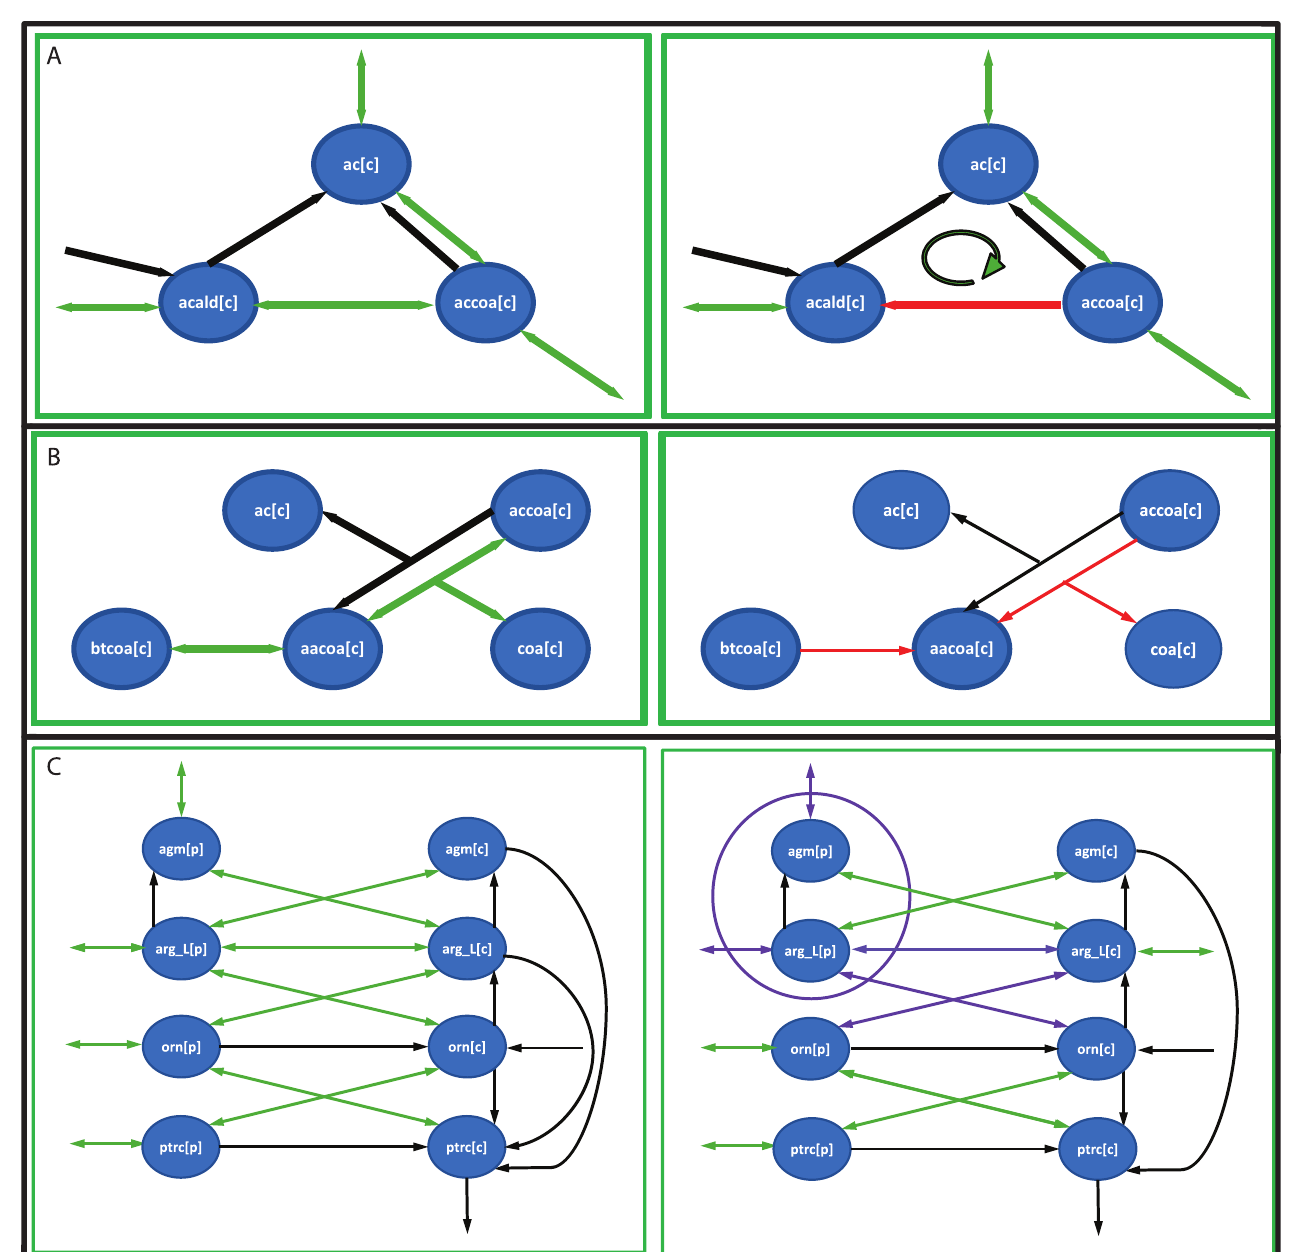
Fig 4. Example of rules to identify infeasible flux patterns. A . Loopless rules for the fatty acid metabolism module. In order to break the loop, the acetaldehyde oxidoreductase reaction (acetaldehyde (acald[c]) to acetyl-coA (accoa[c])) cannot point in the direction of acetaldehyde synthesis (red arrow). B. Local mass balance rules for the fatty acid metabolism module. Around each internal metabolite in the network, there must be at least one reaction in (synthesis) and one out (consumption). In this example, there is one irreversible reaction around acetoacetyl-coA in the synthesis direction, thus at least one of the reversible reactions should go in the consumption direction. C. Two metabolites that are fully mixed for the Arginine metabolism module. As Agmatine (agm[p]) and Arginine (arg_L[p]) are fully mixed, both can actually be seen as only one metabolite, thus a mass balance rule around both metabolites was added. Which means that around fully mixed metabolites there should be at least one reaction in (synthesis) and one out (consumption). In purple are highlighted the 3 reversible reactions around these metabolites. In red are presented the infeasible rules for A and B. Black arrows represent irreversible reactions and green arrows represent reversible